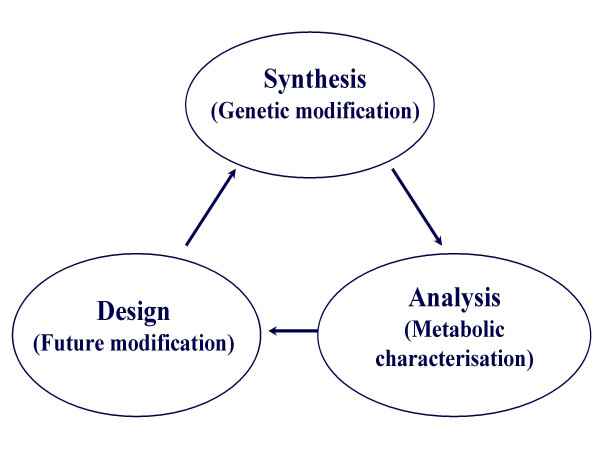
Principe of Metabolic Engineering (adapted from [23]).